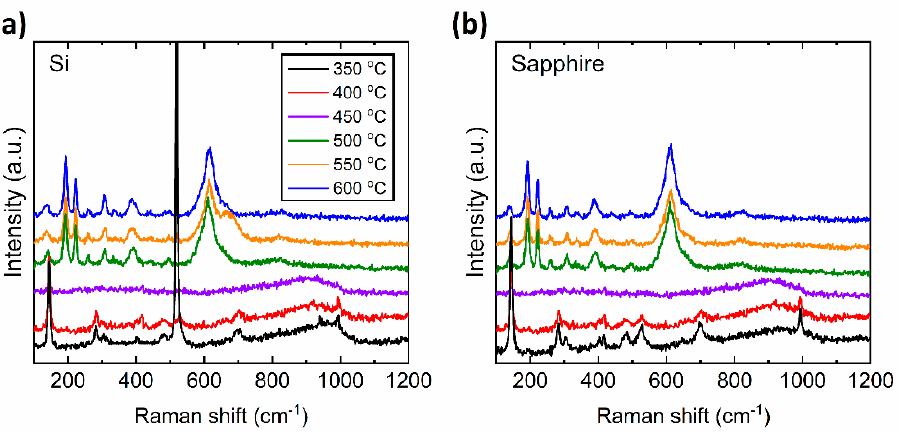
Figure 1. Raman spectra of VO 2 and V 2 O 5 thin films prepared at various substrate temperatures ( T S ) on ( a ) Si and ( b ) sapphire substrates. Note that the vertical axes are in arbitrary units (a.u.), so the relative magnitudes of the spectra cannot be compared.